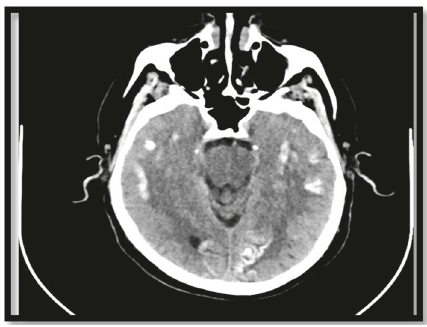
Figure 1: Plain CT of the brain at presentation to the hospital showing patchy and gyriform calcification in bilateral temporopari- etal occipital corticosubcortical areas. Abbreviation: CT, computed tomography.